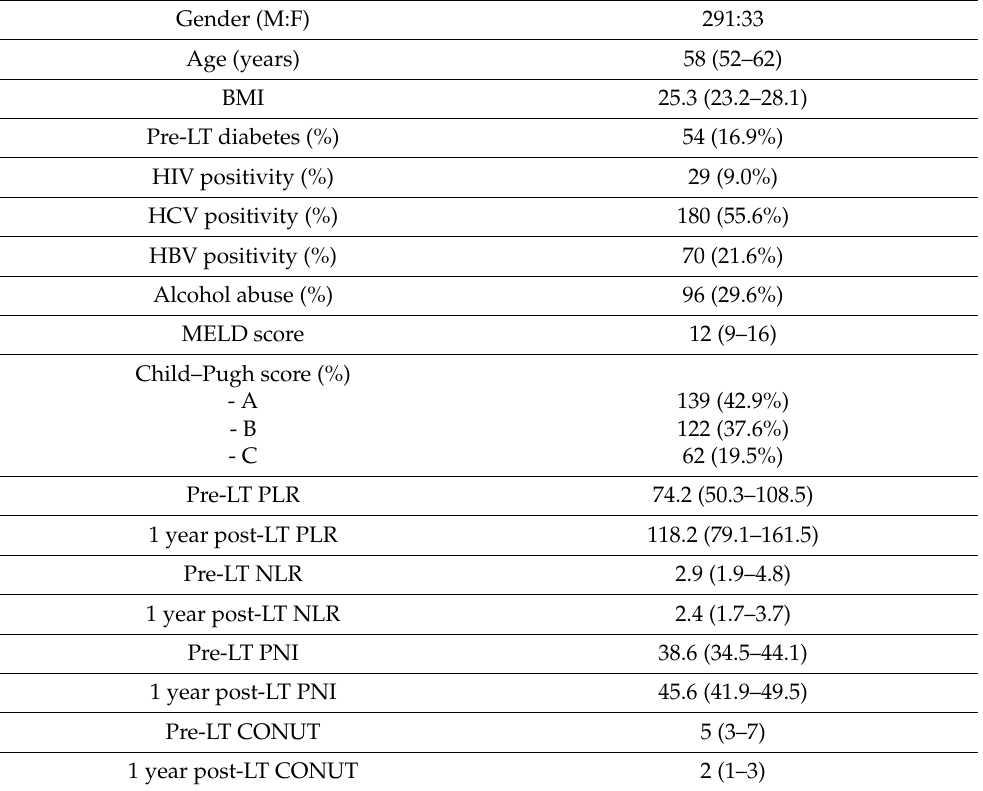
Table 1. Demographic and clinical data on recipients, graft characteristics, and surgical